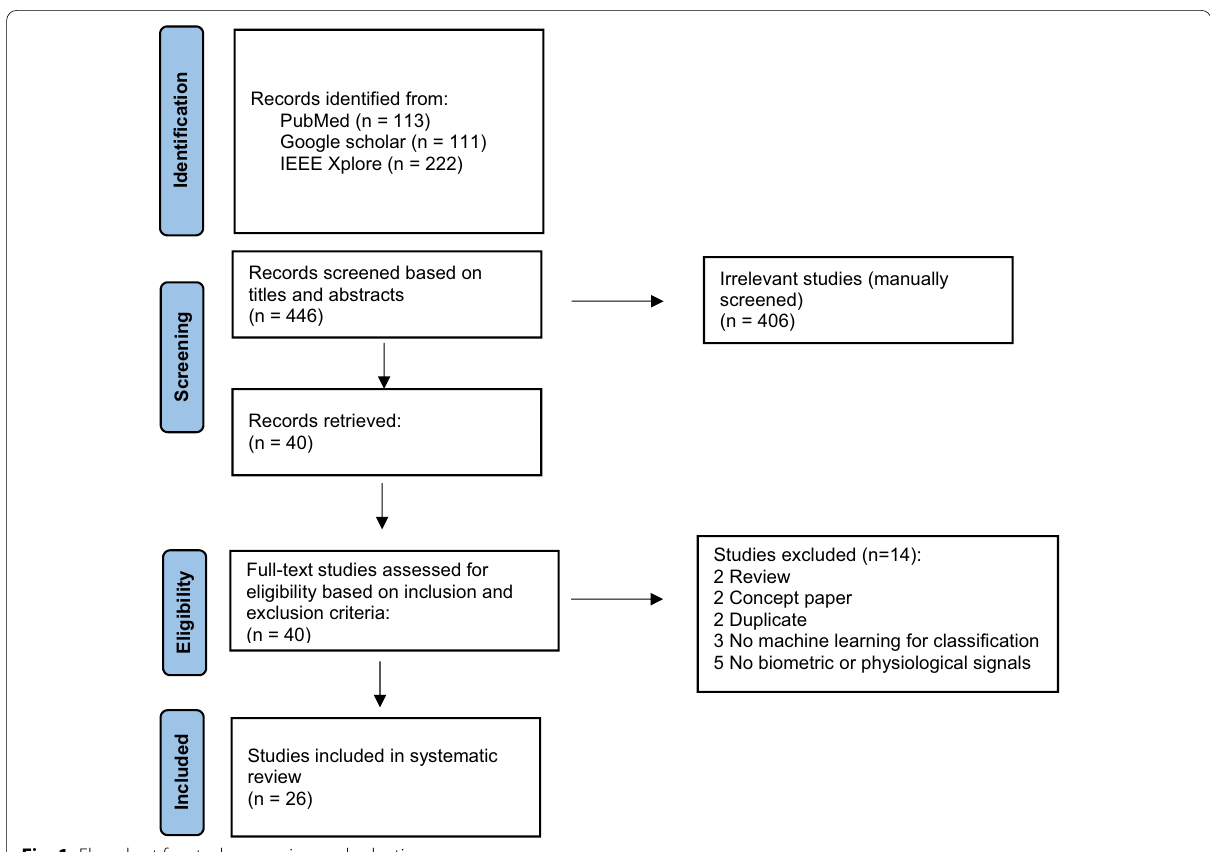
Fig. 1 Flowchart for study screening and selection